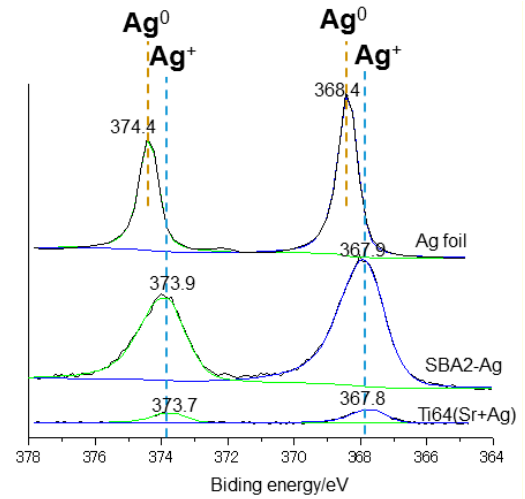
Figure 3. XPS peak profile analysis of the Ag region obtained on Ti64(Sr + Ag) and SBA2-Ag. The peak profile analysis of the Ag region obtained on a metal Ag foil is reported as reference.